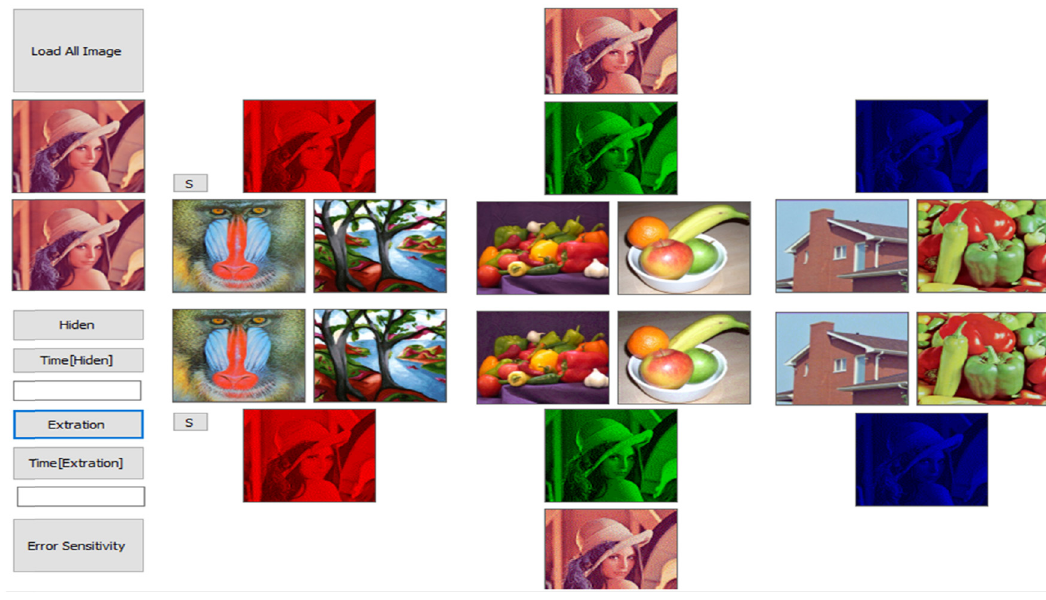
Figure 12: Interface of construction of six meaningful shares image and reconstruction of halftone color secret image SI.